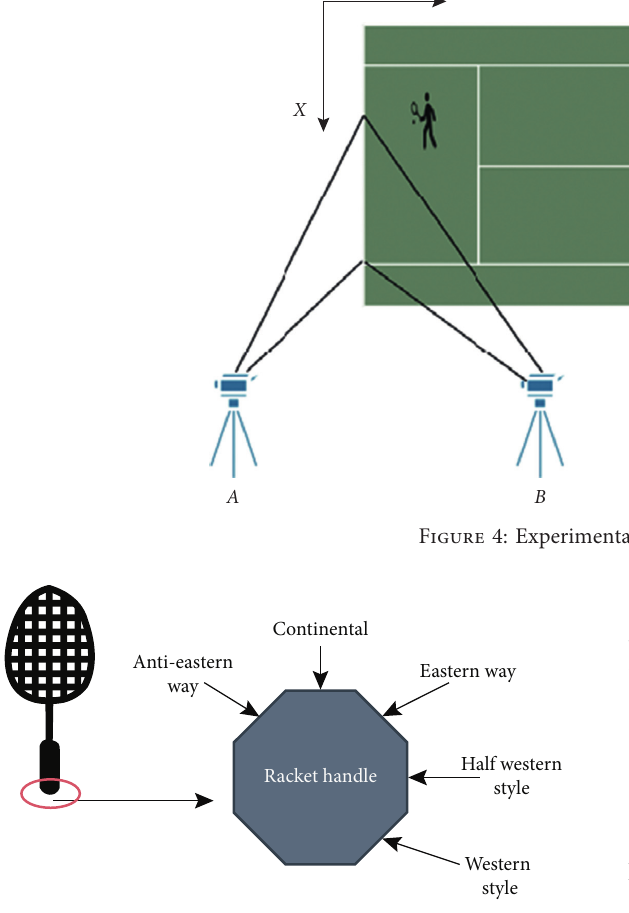
Figure 5: Tennis racket